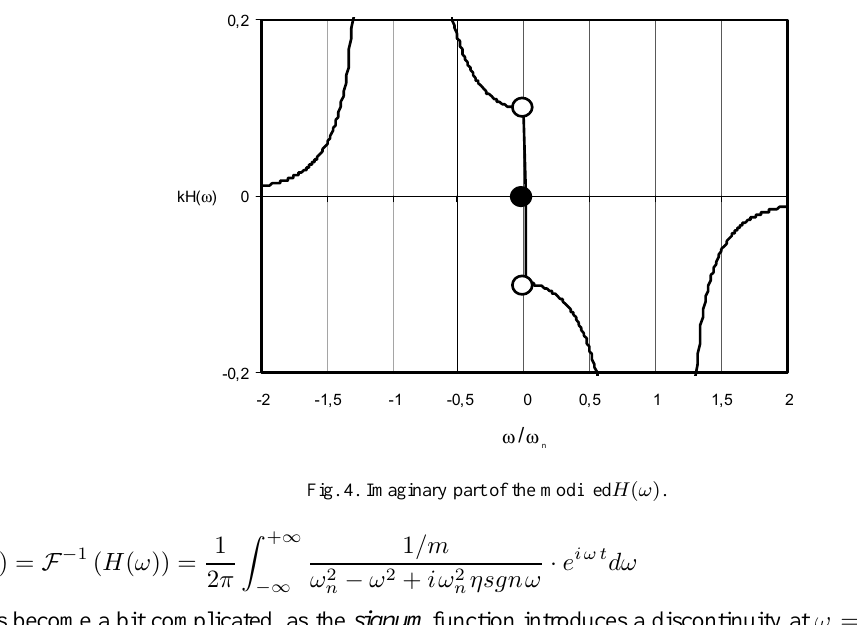
Fig. 4. Imaginary part of the modified H ( ω )